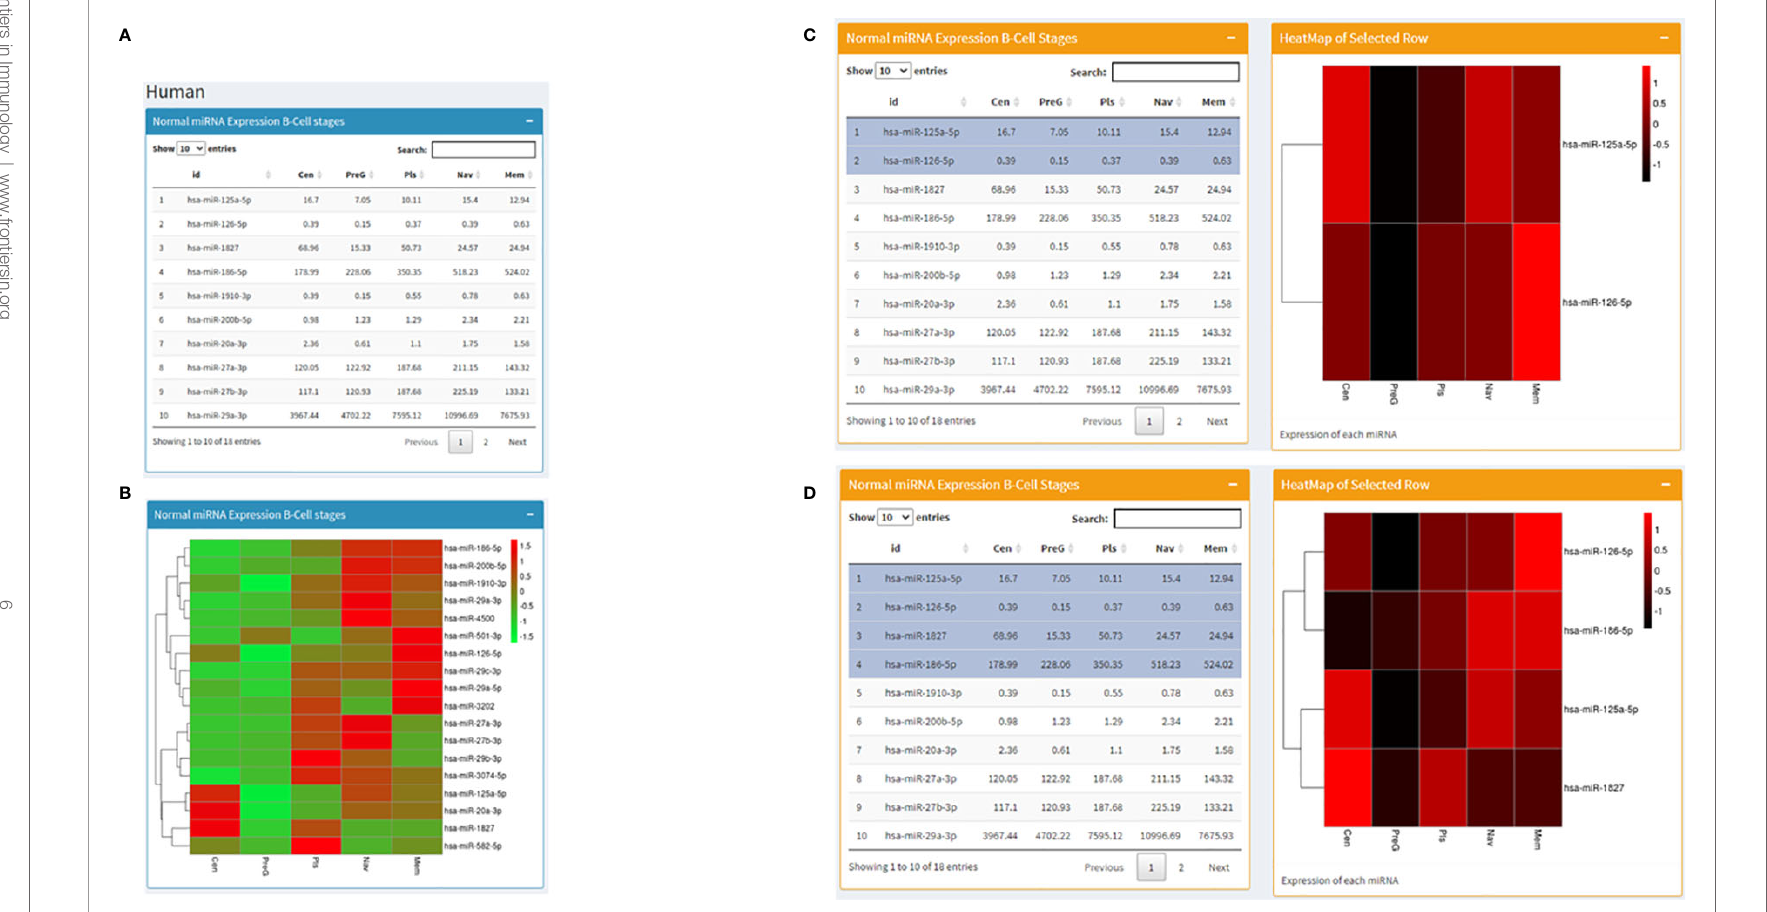
FIGURE 3 | Human page of the database where (A) displays a table with RAG1 miRNA expression across normal B cell development stages and (B) contains the corresponding heatmap; (C, D) set of images represent the utility of the page where heatmaps corresponding to selected miRNA are displayed; (C) has 2 miRNAs selected and (D) has 4 miRNAs selected on the left along with the corresponding heatmaps on the right of the